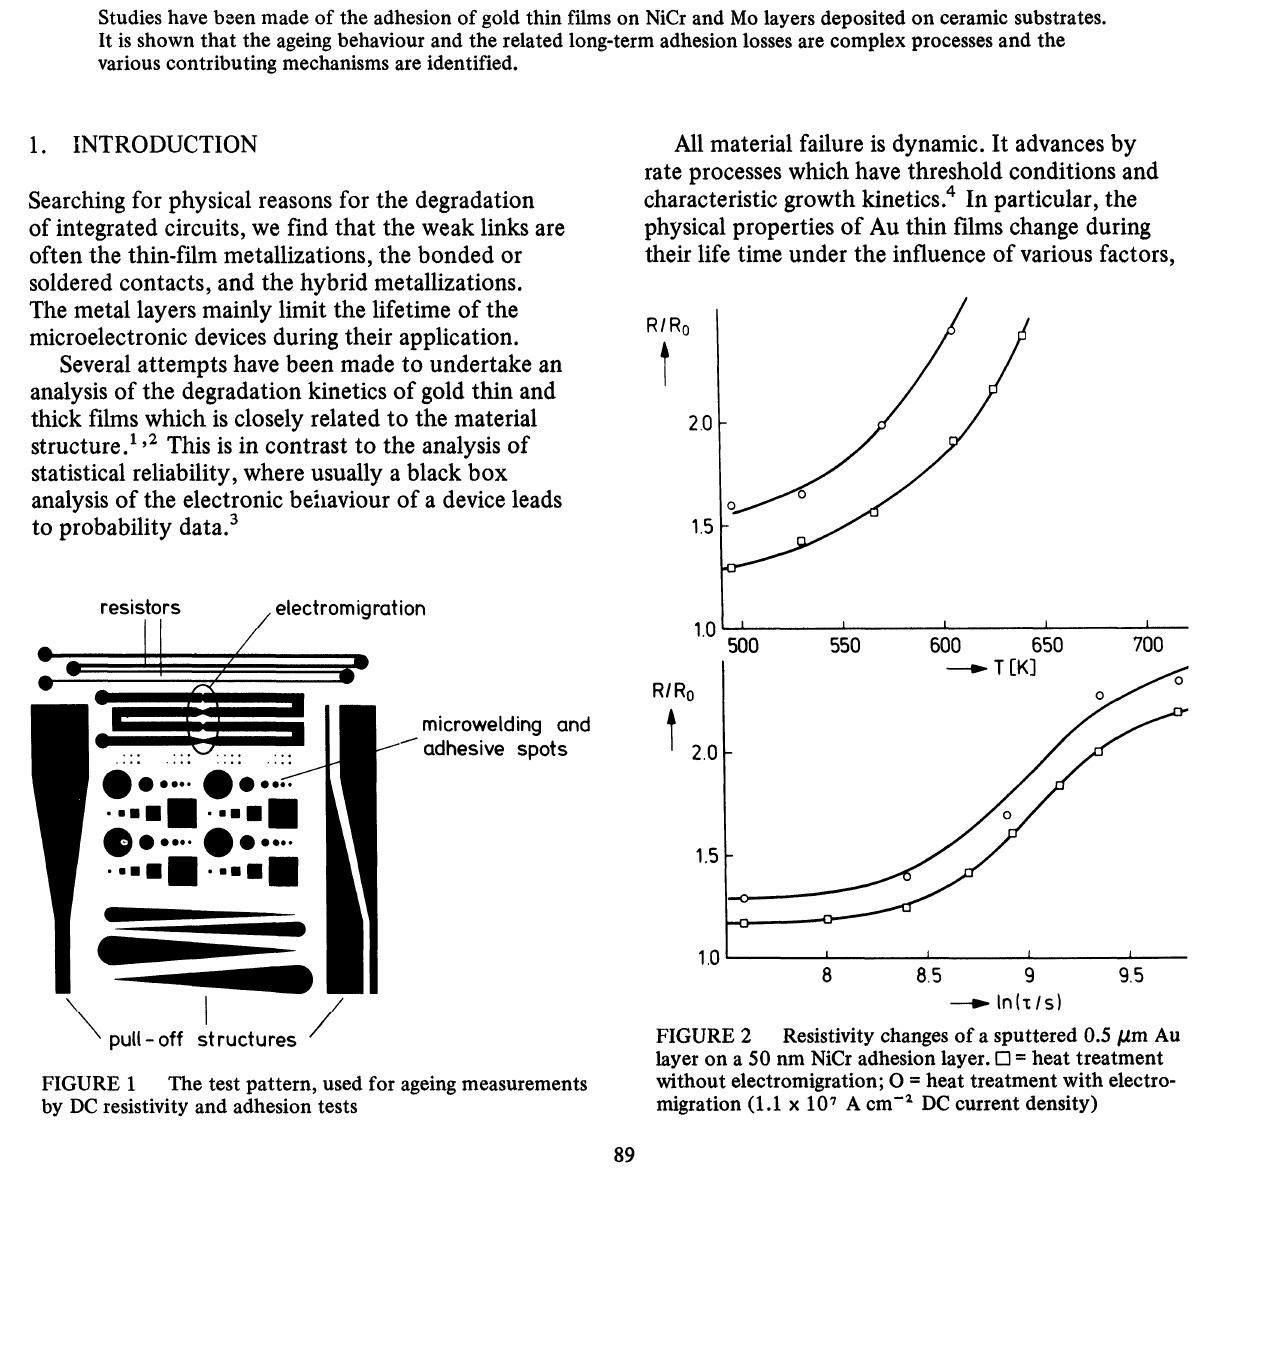
The test pattern, used for ageing measurements by DC resistivity and adhesion tests